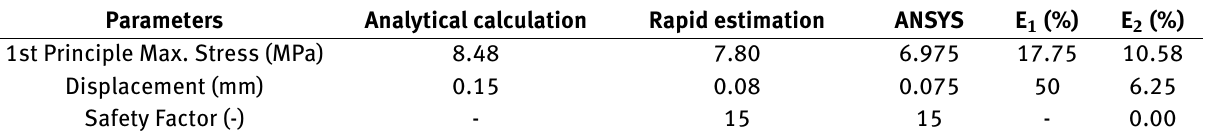
Table 1: Error comparison of the analytical calculations, rapid estimation (Autodesk Inventor) and ANSYS: machine components Parameters